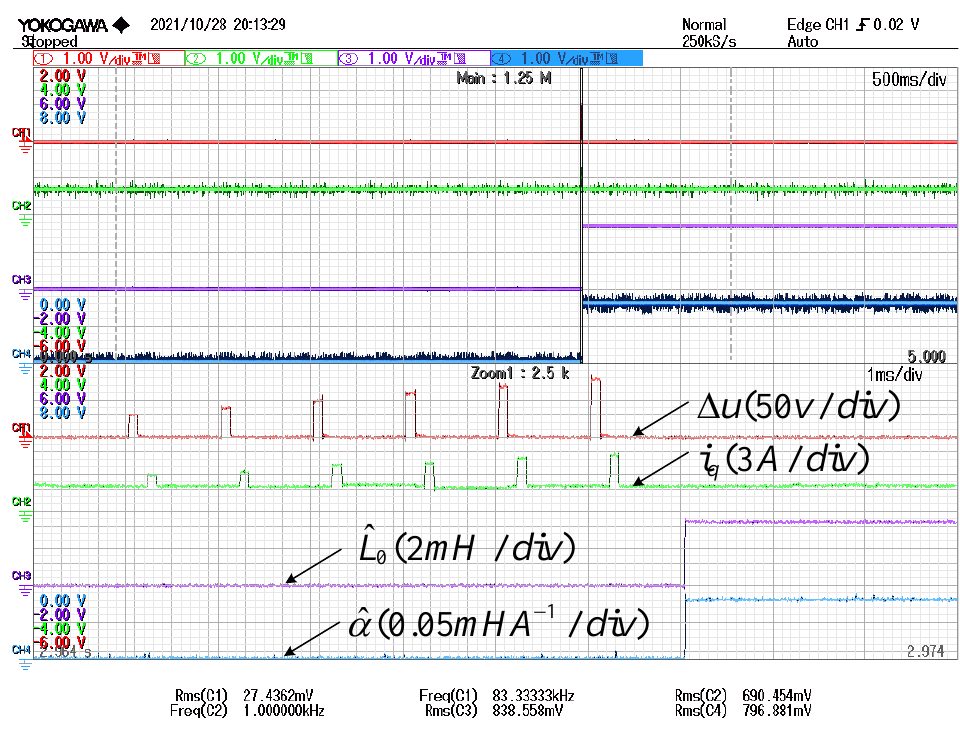
Figure 7. Experiment results of inductance identification.